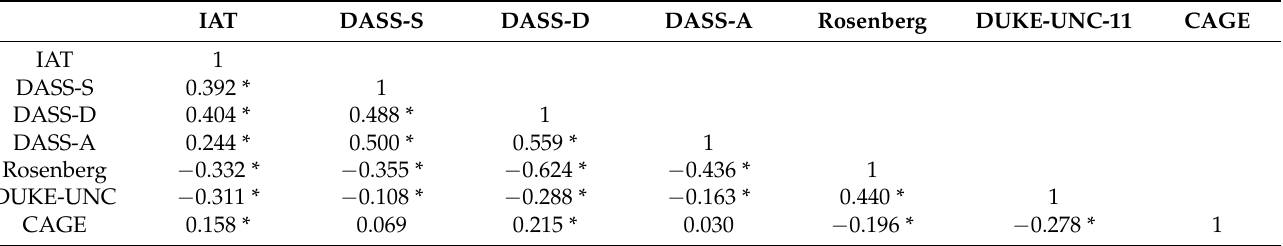
Table 3. Spearman correlation coefficients between the results of the questionnaires ( n = 698).